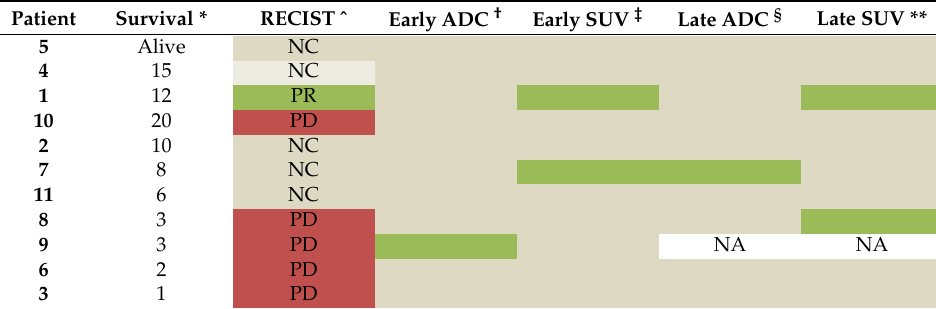
Table 4. Survival and early response on PET/MR.